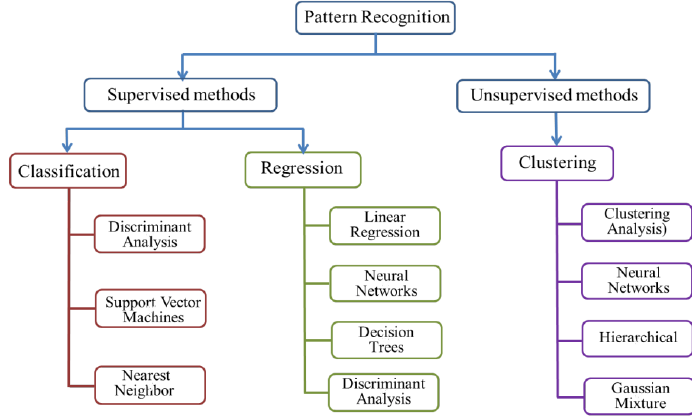
Figure 3 Typical pattern recognition methods applied on E-nose system. Figure 3. Typical pattern recognition methods applied on E-nose